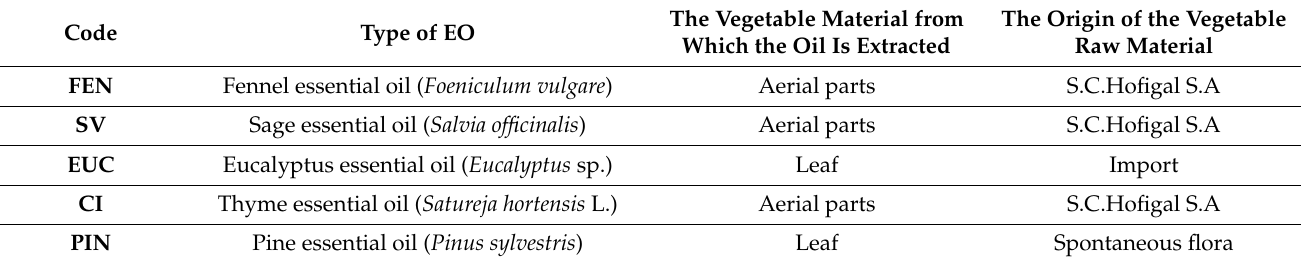
Table 1. Types of essential oils investigated, plant material used, and its